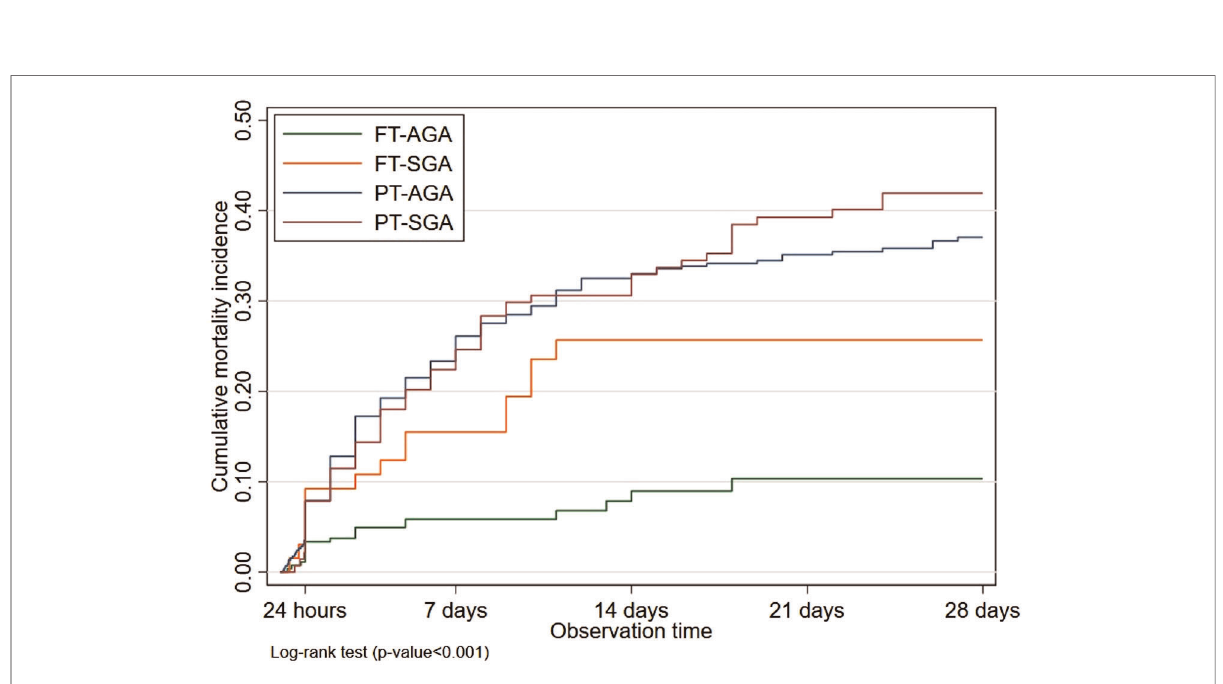
FIGURE 4 Cumulative mortality incidence of respiratory distress in newborns by full term-preterm and AGA-SGA during neonatal